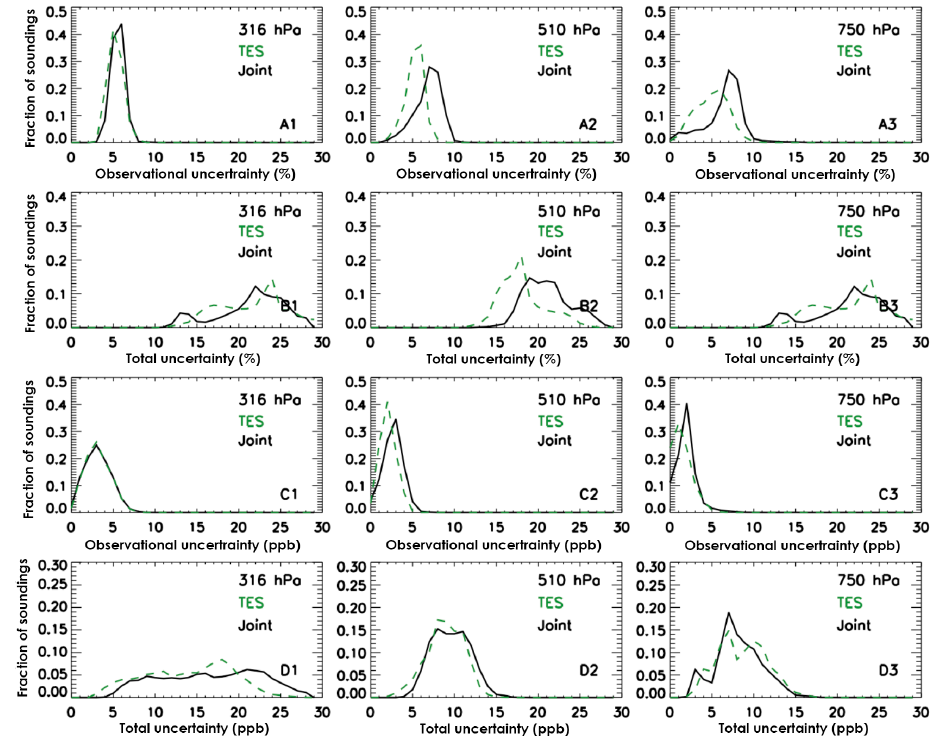
Figure 5. Estimated (predicted) error of retrieved global O 3 concentration shown in Fig. 3. Here, we used the A-Train measurements from August 2006. Results for the remaining months of 2006 are available in Figs. S23–S33 in the Supplement. (A1–A3) Observational error; (B1–B3) total error; (C1–C3) observational error in ppb; and (D1–D3) total error in ppb. Joint AIRS + OMI data are shown as a black line, and TES version 6 data are shown as a green dashed